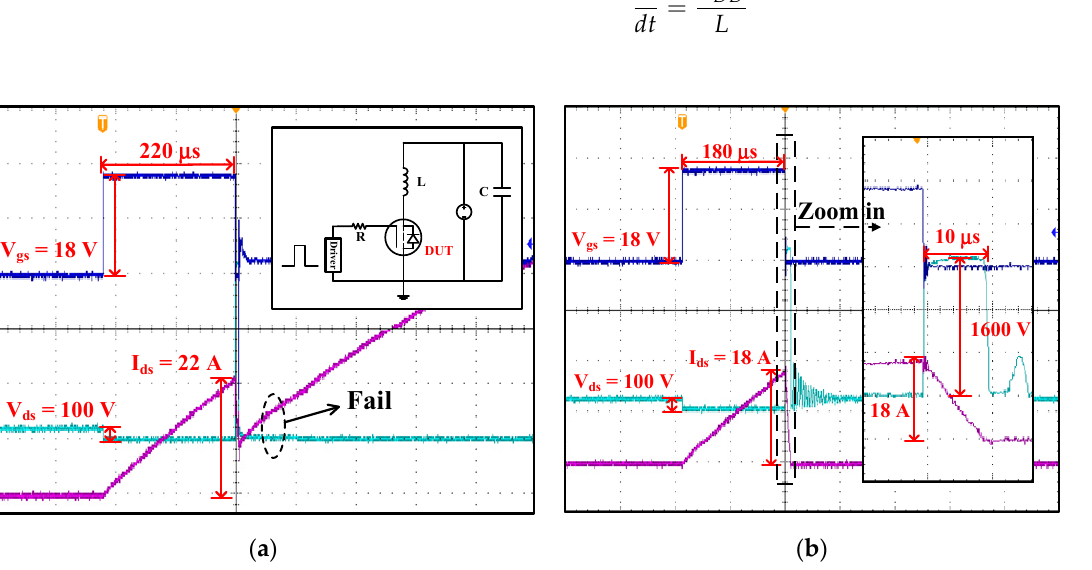
Figure 2. The avalanche waveforms of the asymmetric trench SiC MOSFET. ( a ) The failure waveforms and the schematic circuit diagram of the avalanche stress system. ( b ) The waveforms adopted to stress the